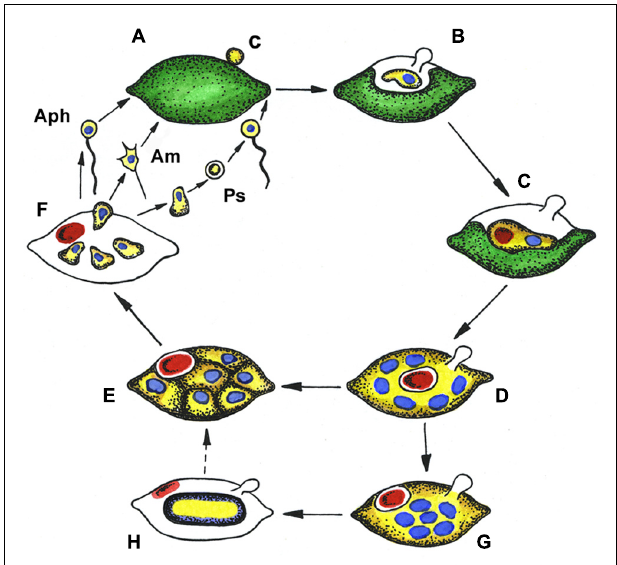
FIGURE 4 |Amoeboid zoospores of Amoeboaphelidium protococcarum. Living cells observed using phase contrast. (A–C) Strain x-1 CALU, (D–G) strain x-5 CALU. (H) Amoeba of Amoeboaphelidium protococcarum strain x-5 CALU on ultrathin longitudinal section. (D–H) After: Karpov etal. (2013). f and black arrows, filopodia often producing by broad anterior pseudopodium (ps, white arrow), m, mitochondrium, n, nucleus, arrowheads show pseudocilium. Scale bars: A–C , 3 μ m; D–G , 2 μ m; H , 1 μ m. surface of the parasitoid. The plasmodium then slightly constricts, produces a thick yellowish cell wall inside the empty host and becomes a resting cyst or dormant spore ( Figure 2 ). The nuclei of the spore aggregate into the central irregular mass. During germi- nation a spore wall becomes thin and colorless, and the plasmod- ium divides into several rounded cells. Further proliferation is not